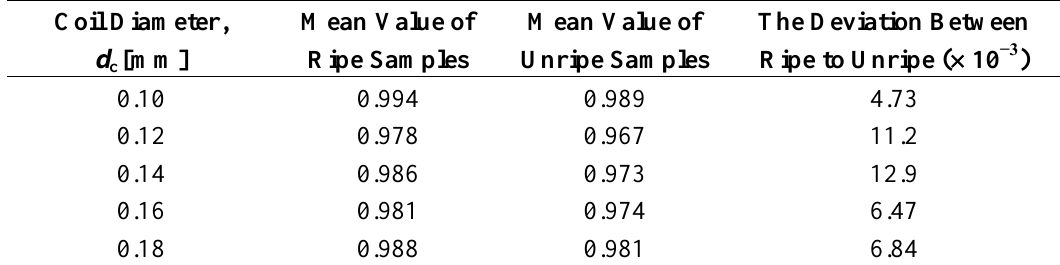
Table 3. The deviation between mean value of ripe samples and unripe samples for 5 mm air coil length.